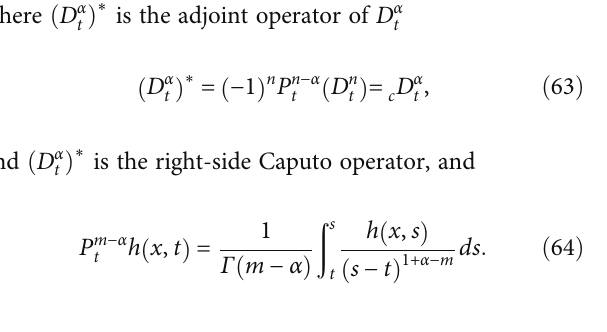
ð x , t Þ of Equation (1) for a 3